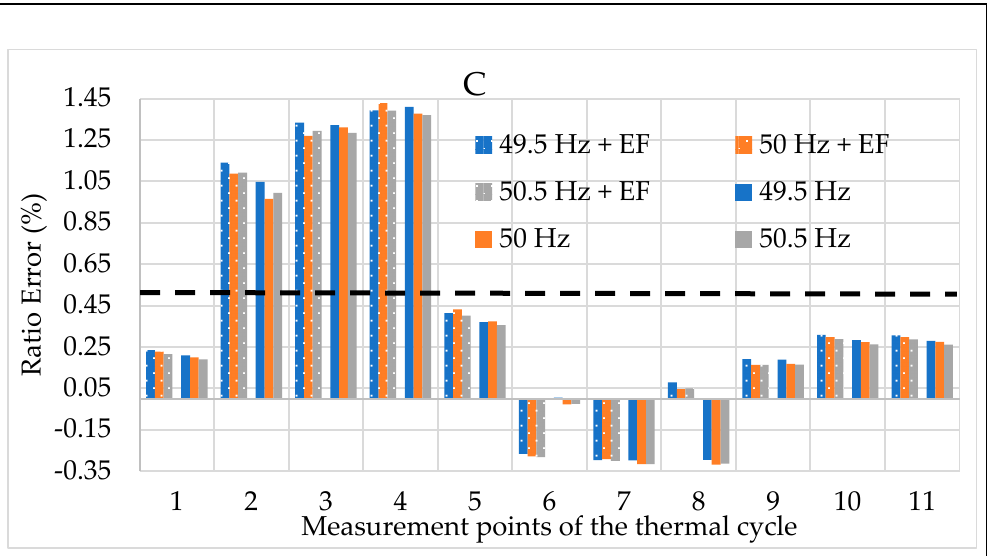
Figure 21. Ratio error vs. the three influence quantities for LPVT C.